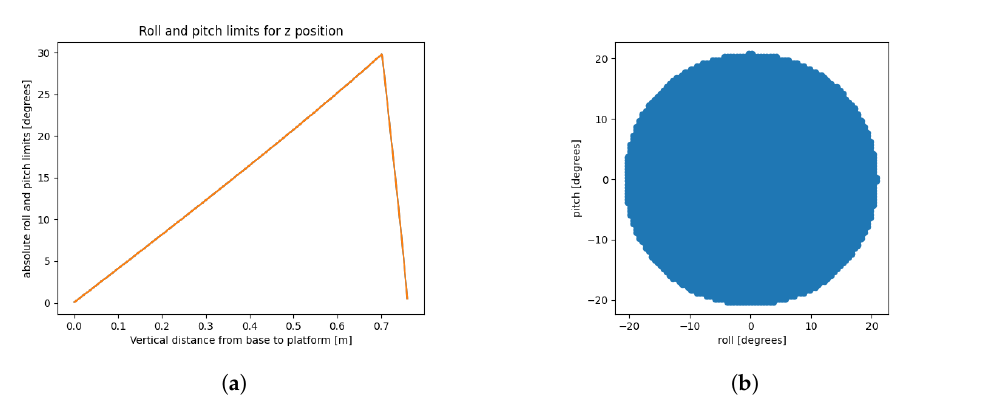
Figure 8. Roll and pitch limit analysis: ( a ) Roll and pitch limit variation with distance between platforms; ( b ) Allowed platform orientation in degrees for z = 0.5 m.